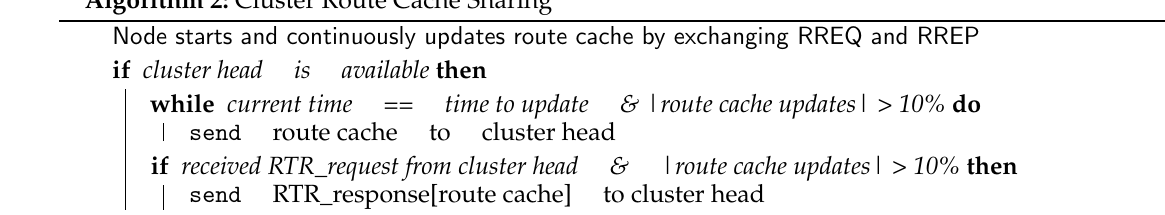
Algorithm 2: Cluster Route Cache